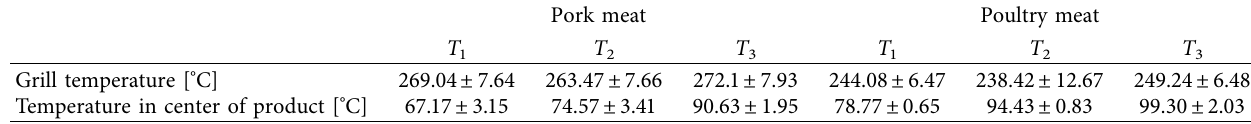
Table 1: Summary of the heating parameters for samples prepared using three grilling working regimes.